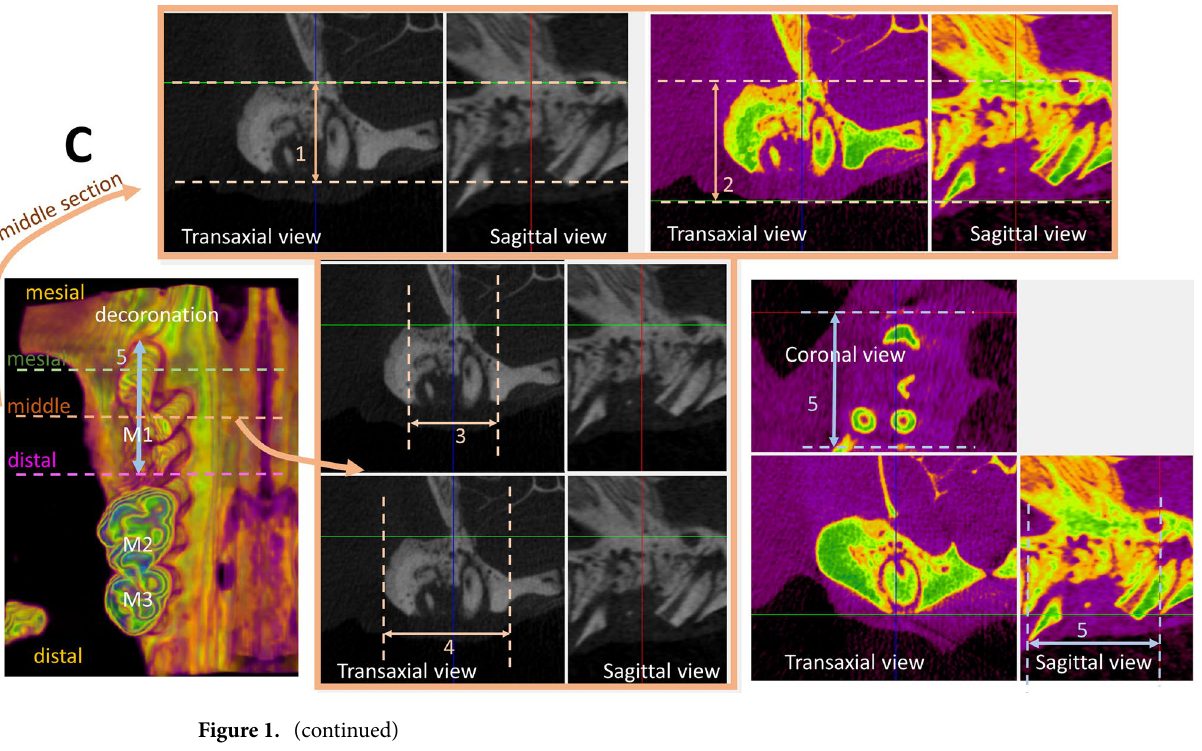
Table 3, middle bone height ranged from 2.156 ± 0.262 mm (6th week) to 2.319 ± 0.174 mm (14th week); middle soft tissue height ranged from 3.094 ± 0.077 mm (10th week) to 3.429 ± 0.343 mm (14th week); middle alveolar crestal width ranged from 2.808 ± 0.075 mm (10th week) to 3.180 ± 0.333 mm (2nd week); middle maximum bone width ranged from 3.533 ± 0.228 mm (10th week) to 4.221 ± 0.107 mm (14th week); and mesio-distal